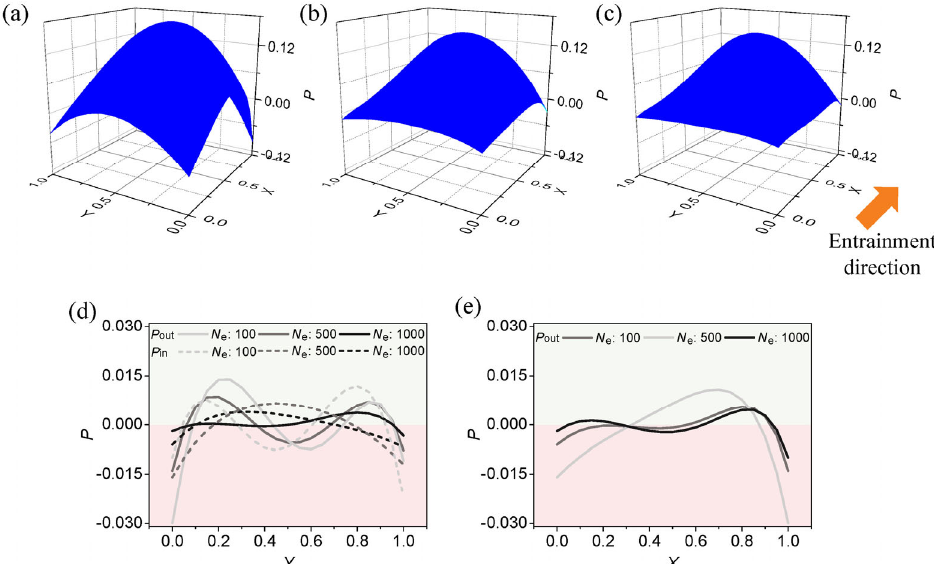
Fig. 4 Convergence of calculated pressures with the increment in N e . Inside the lubrication domain: (a) N e = 100, (b) N e = 500, (c) N e = 1,000 and at boundaries, (d) the inlet and outlet, and (e) side edges.